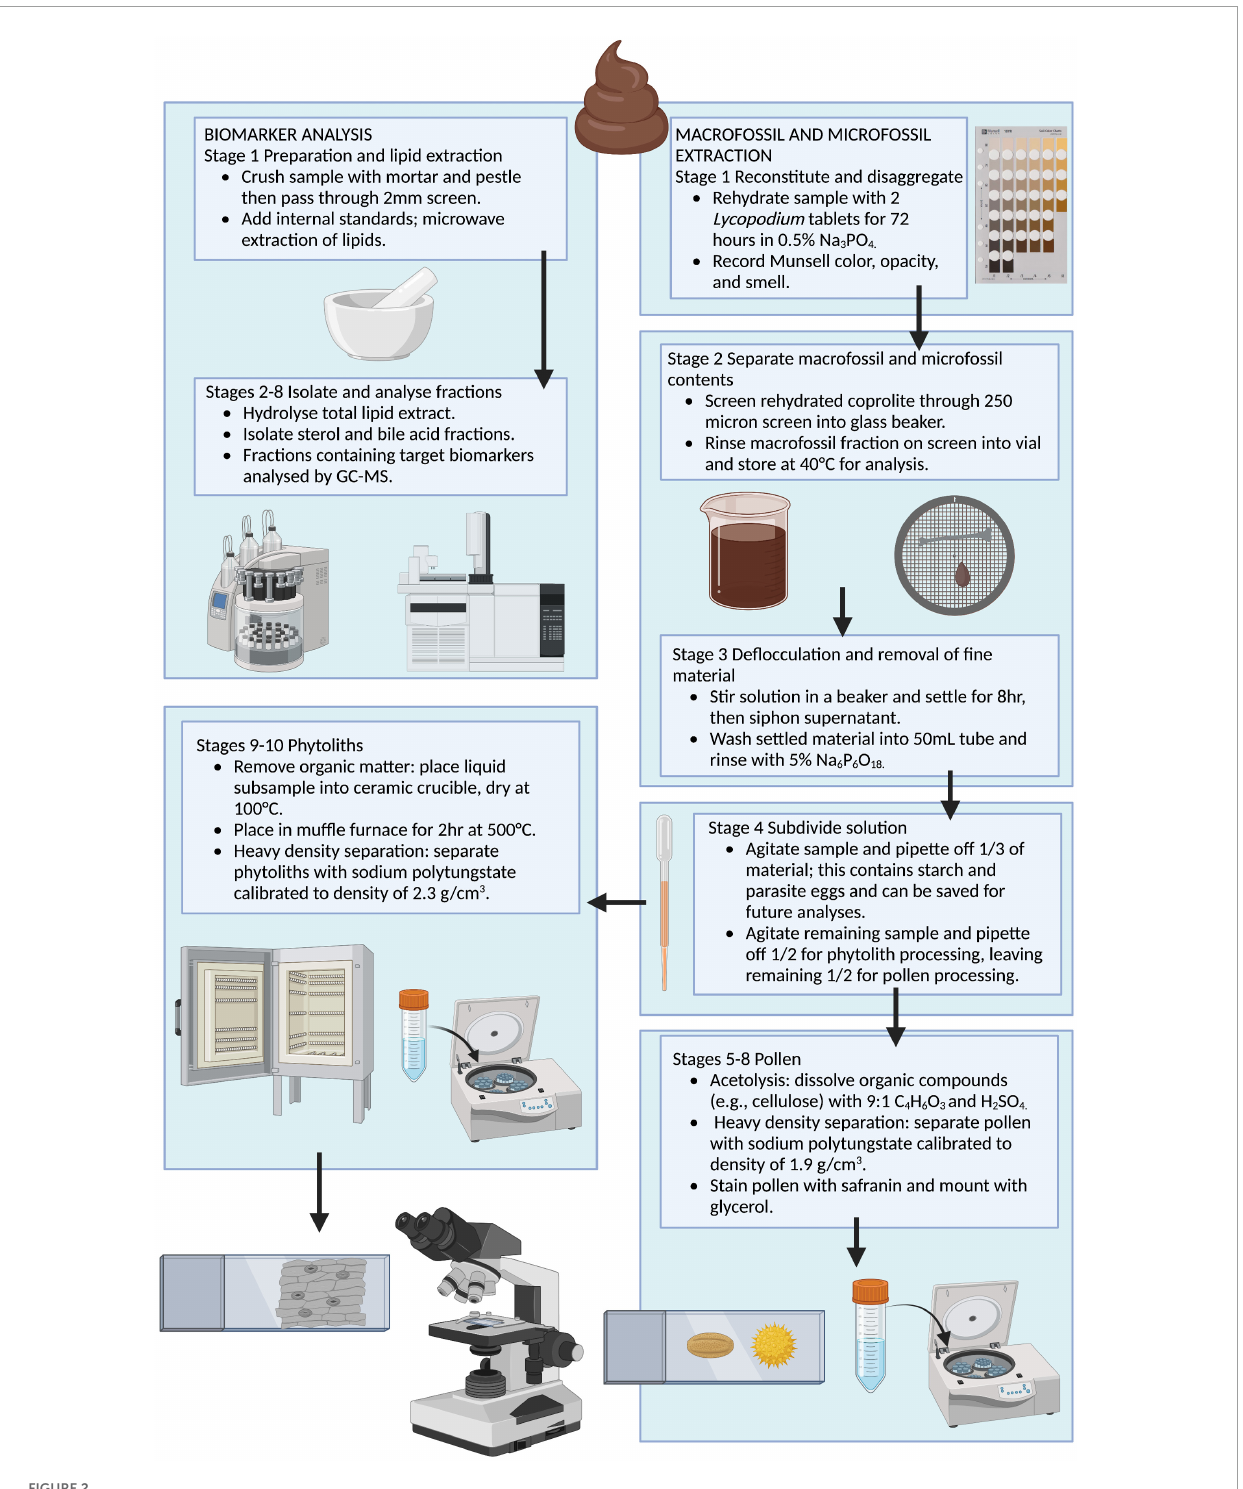
FIGURE2 Flow chart illustrating the sequential biomolecular, macrofossil, and microfossil extraction method for coprolites. Created with Biorender.com.